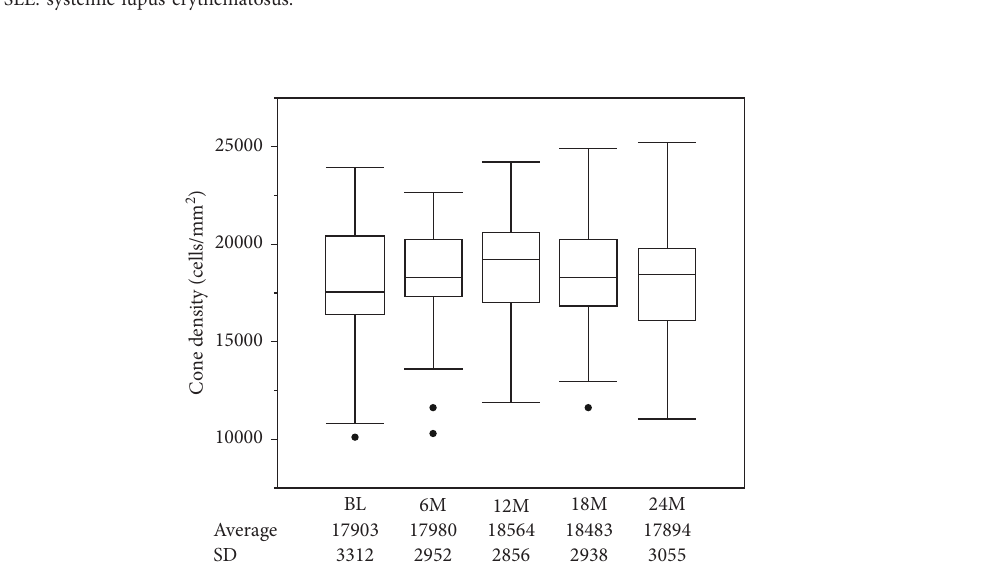
Figure 1: The mean cone density showed no significant change at 6, 12, 18, and 24 months compared with baseline ( P � 0 . 145, P � 0 . 171, P � 0 . 097, and P � 0 . 866, respectively) ( n �